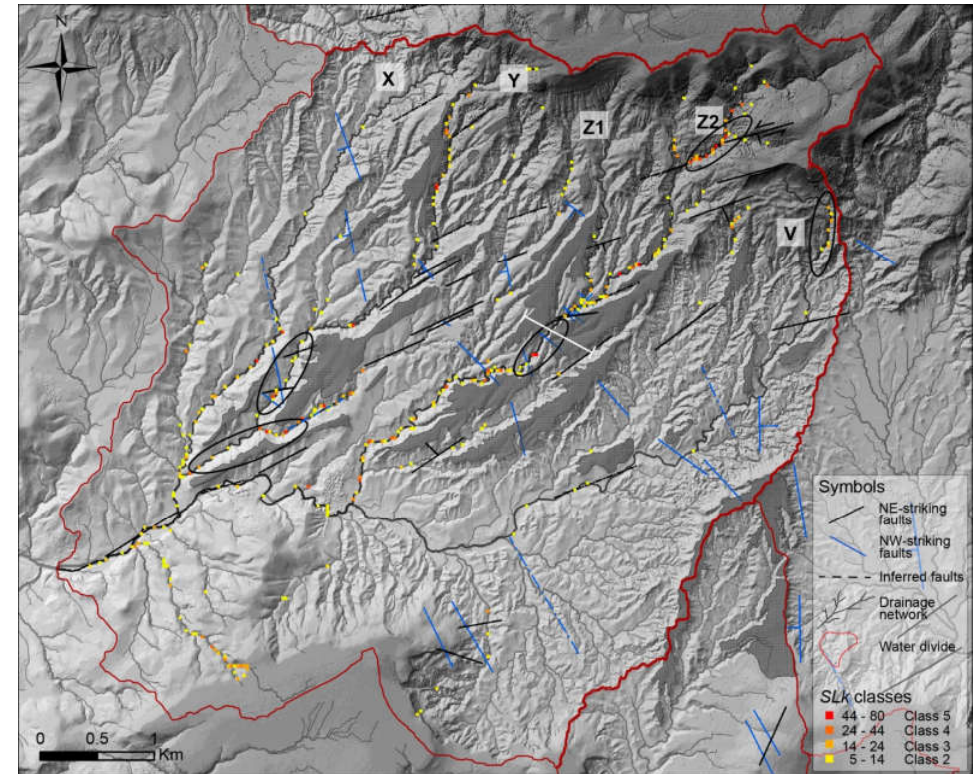
Figure 5. Morphology map with SLk indexes and NW and NE striking faults for the Geren catchment. Five gullies used for further visualisation are highlighted (X, Y, Z1, Z2, V, see text). Plateaux surfaces (dark grey) are indicated alongside the watershed of the Geren catchment. Circles indicate high SLk -index values (see text). Modified from [90].